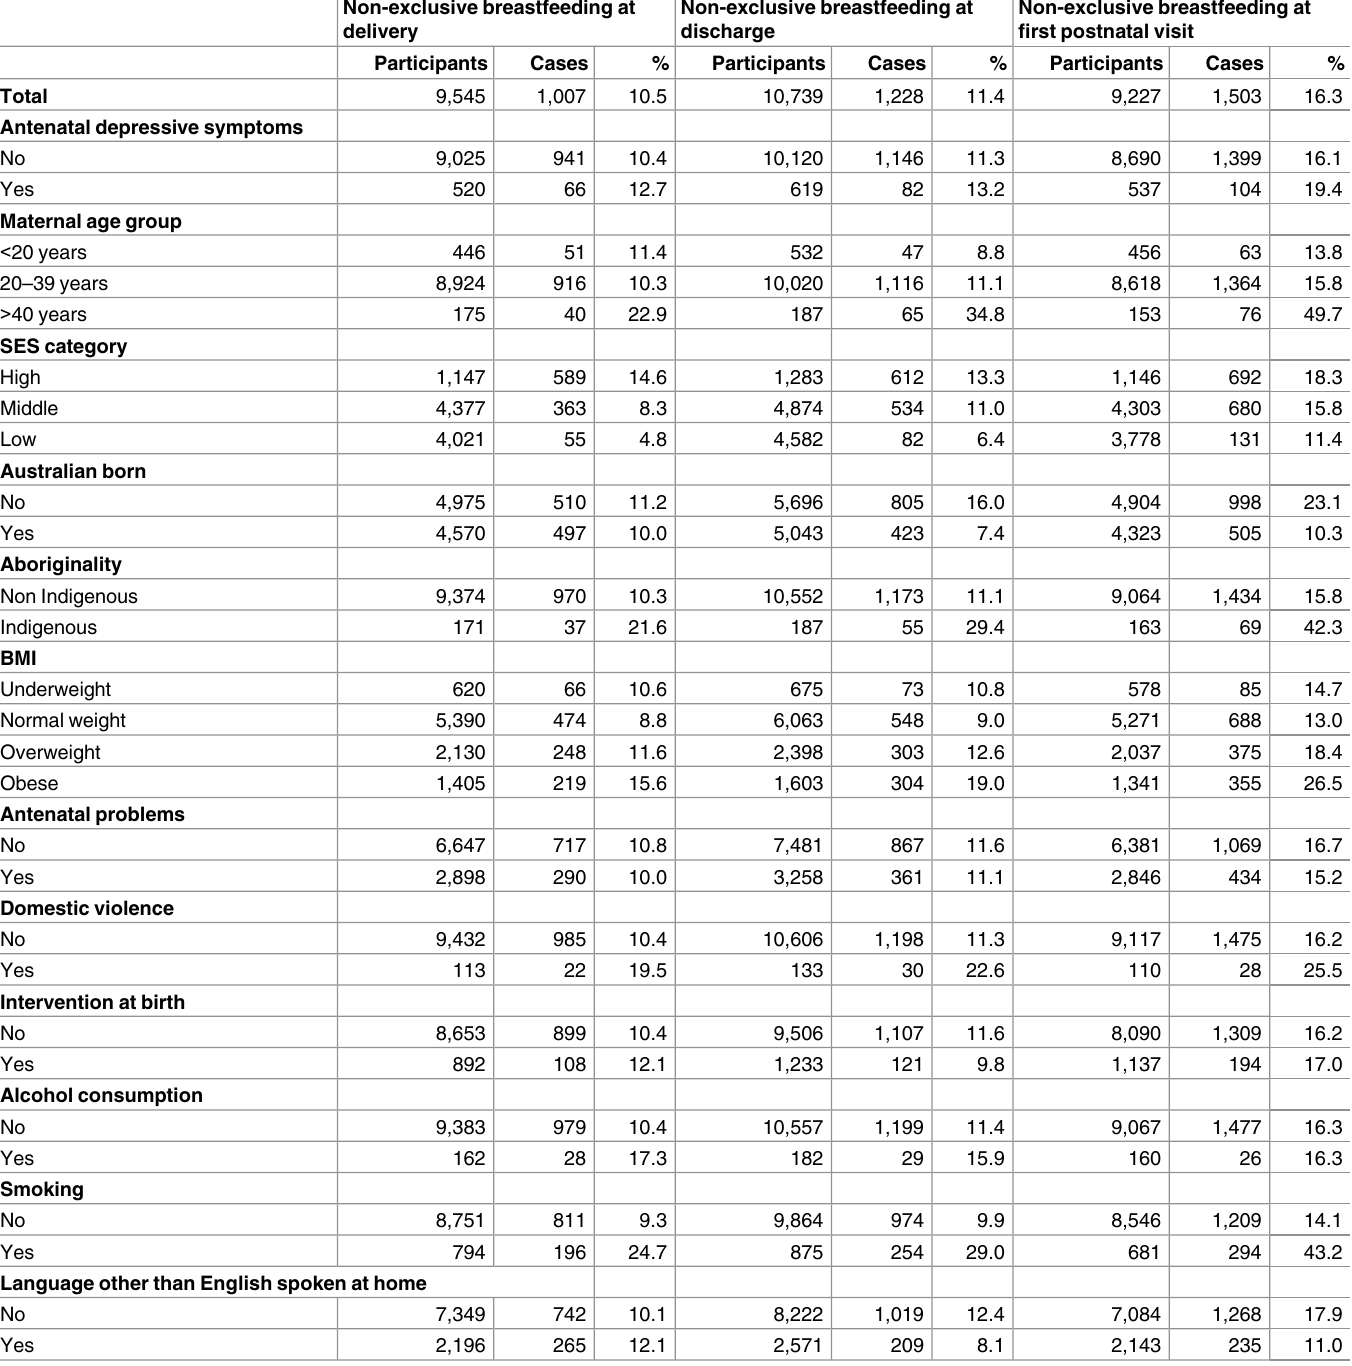
Table 2. Prevalence of breast feeding indicators by study